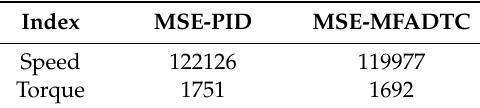
Table 2. MSE indices with